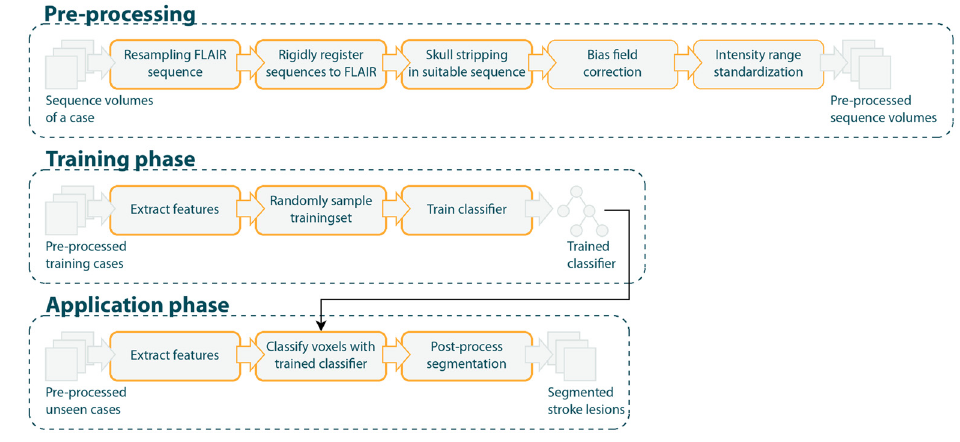
Fig 1. Processing